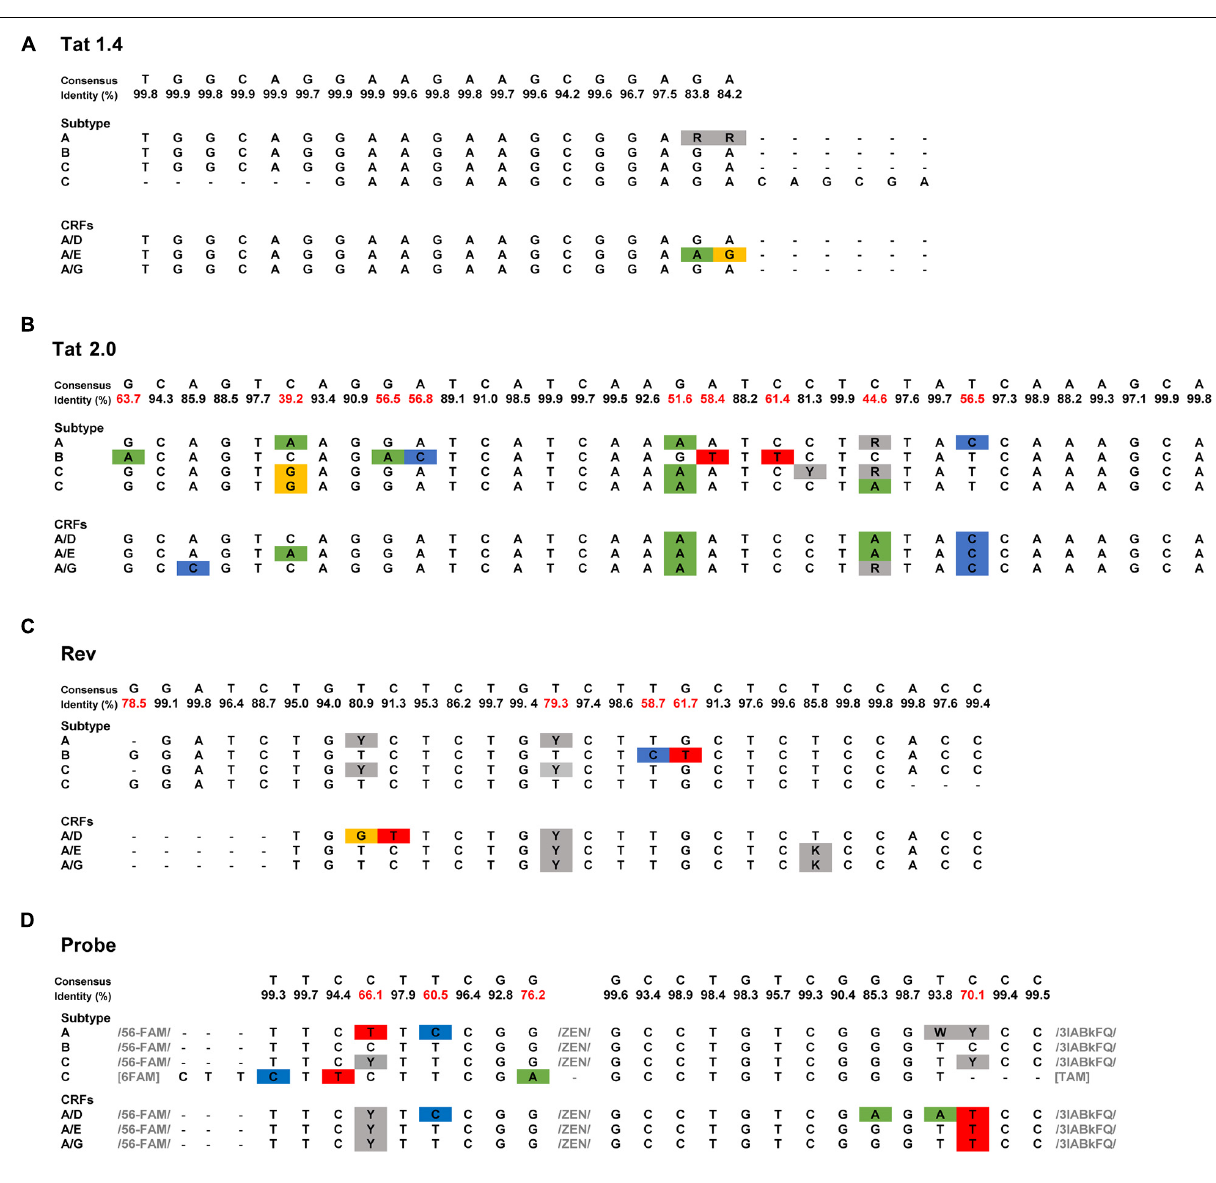
FIGURE 1 | Sequence of TILDA primers and probes specific for different HIV-1 subtypes. (A–D) TILDA primer and probe sequences were retrieved from the literature [HIV-1 subtype: A (Dhummakupt et al., 2020), B (Procopio et al., 2015), C (Bertoldi et al., 2020; Dhummakupt et al., 2020), A/E (Colby et al., 2018), A/D, and A/G (Dhummakupt et al., 2020)] and aligned to a consensus sequence generated from an alignment of 2695 HIV-1 sequences downloaded from the Los Alamos HIV-1 sequence database. Nucleotide substitutions are colored blue, green, yellow, and red. Nucleotide positions with degenerate bases are colored gray. The least conserved nucleotide positions ( < 80% identity) are marked in